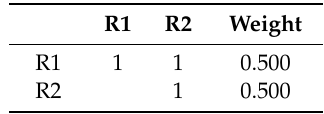
Table A1. Pairwise comparison matrix of Resources indicators.